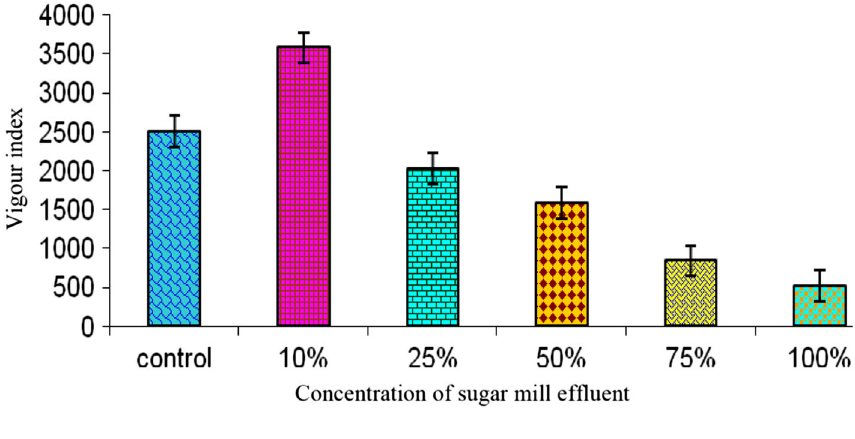
Fig. 5 Tolerance index of Tagetes erecta L. grown under different concentrations of sugar mill effluent